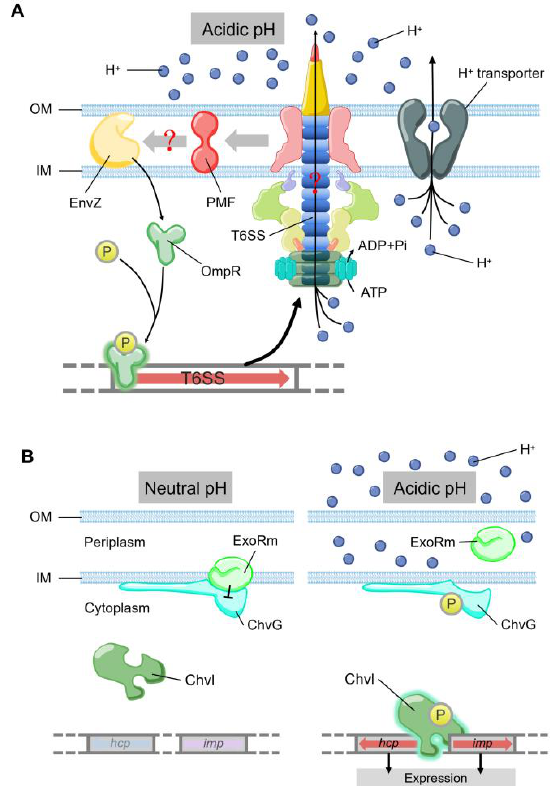
Figure 3. ( A ) The model of T6SS-mediated acid resistance in Y. pseudotuberculosis. EnvZ receives the acidic pH signal to promote the phosphorylation of OmpR, which activates the expression of T6SS. T6SS maintains the pH homeostasis by H + extrusion via the ATPase activity of ClpV4. ( B )